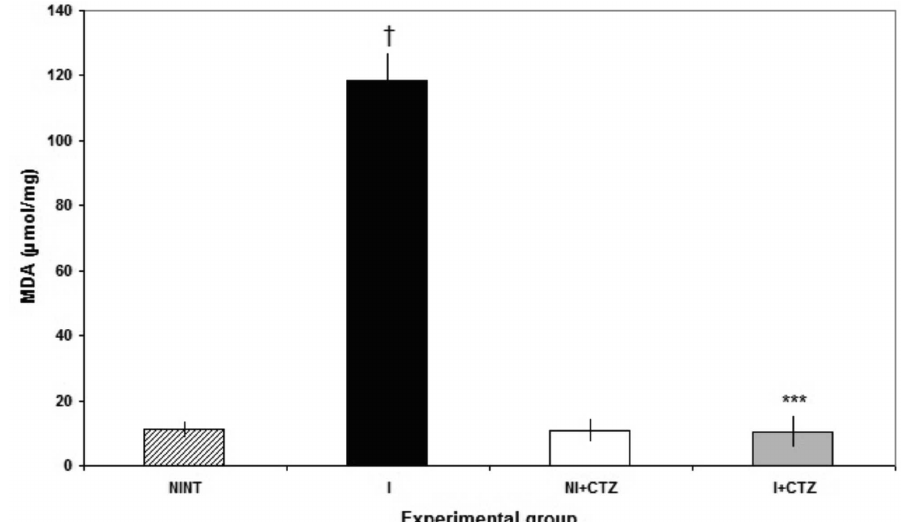
FIGURE 4 - Effect of clotrimazole (CTZ) on lipid peroxidation in Plasmodium berghei -infected erythrocytes. Results are expressed as the mean ± SEM of MDA levels per mg of proteins. NINT: non-infected and non-treated erythrocytes; NI + CTZ: non-infected red blood cells and treated with CTZ; I: infected erythrocytes; I + CTZ: infected red blood cells and treated with CTZ. *** p <0.01 compared I; † p <0.001 compared to